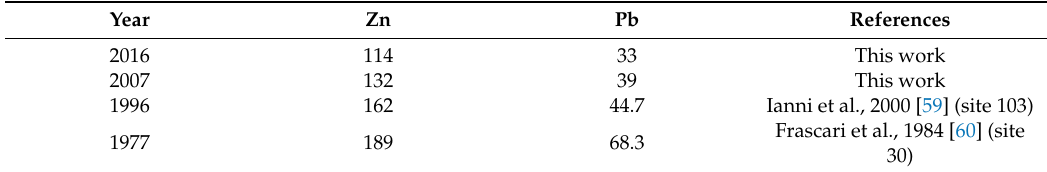
Table 5. Trace metals concentration detected in the S1 area over the time (data from this work and from